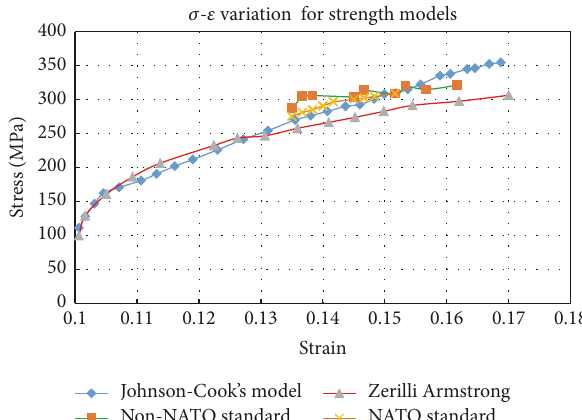
Figure 12: Curve fitting of experimental and model